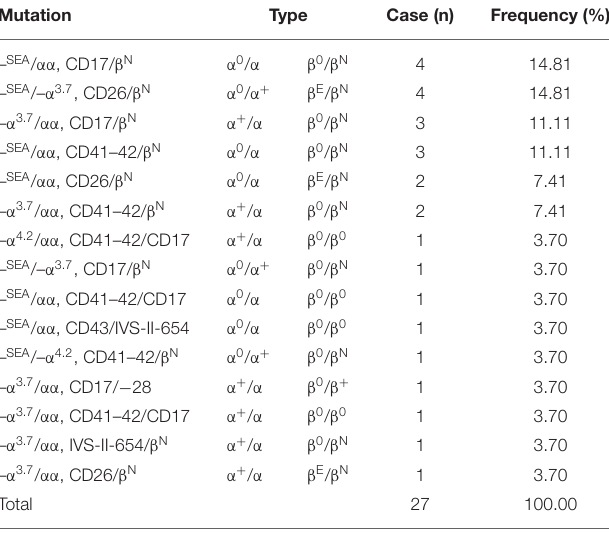
TABLE 3 | Distribution of carriers of both α - and β -thalassemia genotypes in children in Yunnan province.